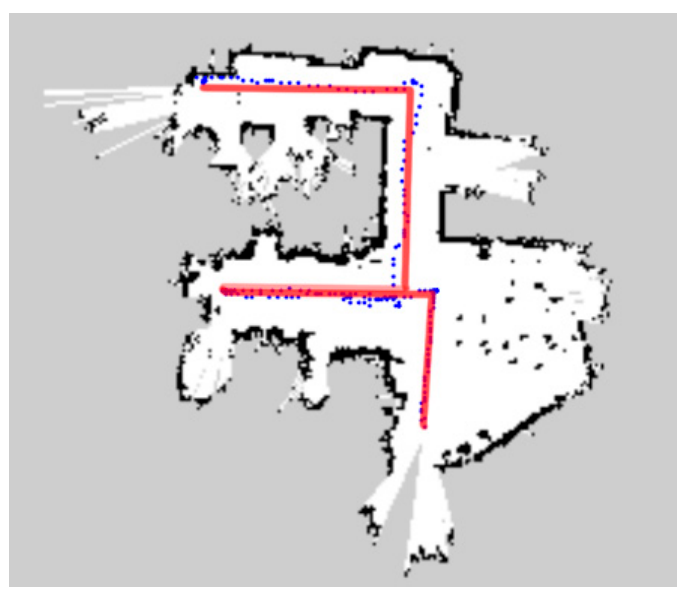
Figure 17. Planned and ideal path in apartment. Table 2. Comparison between path length of planned path and ideal path.